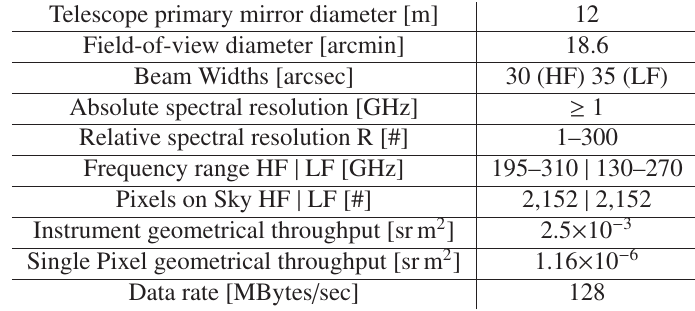
the o ↵ -line analysis. In addition, instead of the sky itself, the second input can be taken from a cold reference, which is a cold black-body at a given tunable temperature.